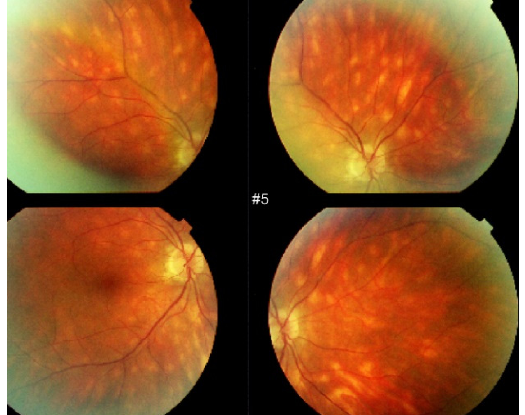
Figure 2. HLA-A29 birdshot retinochoroiditis. Rice shaped cream coloured birdshot lesions.